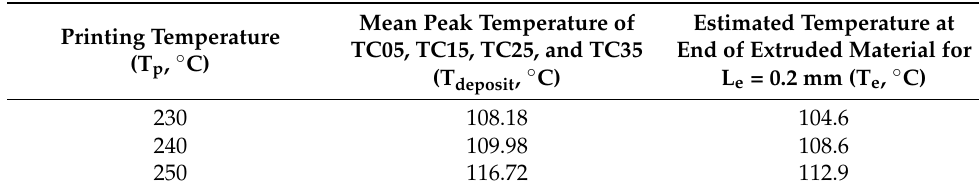
Figure 11. Temperature histories and peak temperatures measured at TC05, TC15, TC25, and TC 35 during the deposition process using different printing temperatures: ( a ) T p = 230 °C; ( b ) T p = 240 °C; ( c ) T p = 250 °C. Table 7. Comparison of mean peak temperature of thermocouples and estimated temperature at end of filament for L e = 0.2 mm using different printing temperatures.